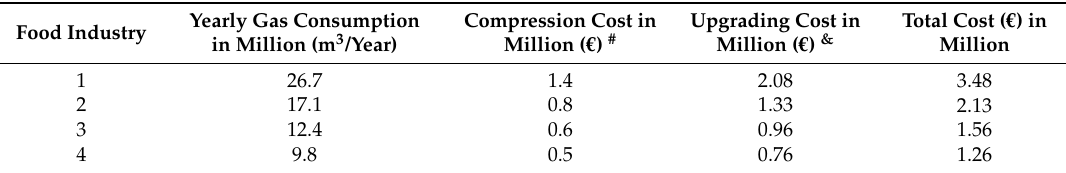
Table 2. Gas consumption by food processing industries and economic calculation of compression and upgrading equivalent amount of